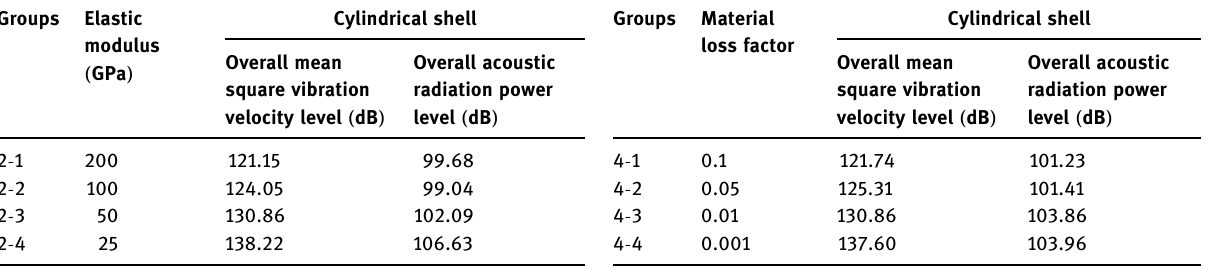
Table 2: The overall vibration level and the overall sound power level of the shell with di ff erent elastic moduli of materials Groups Elastic